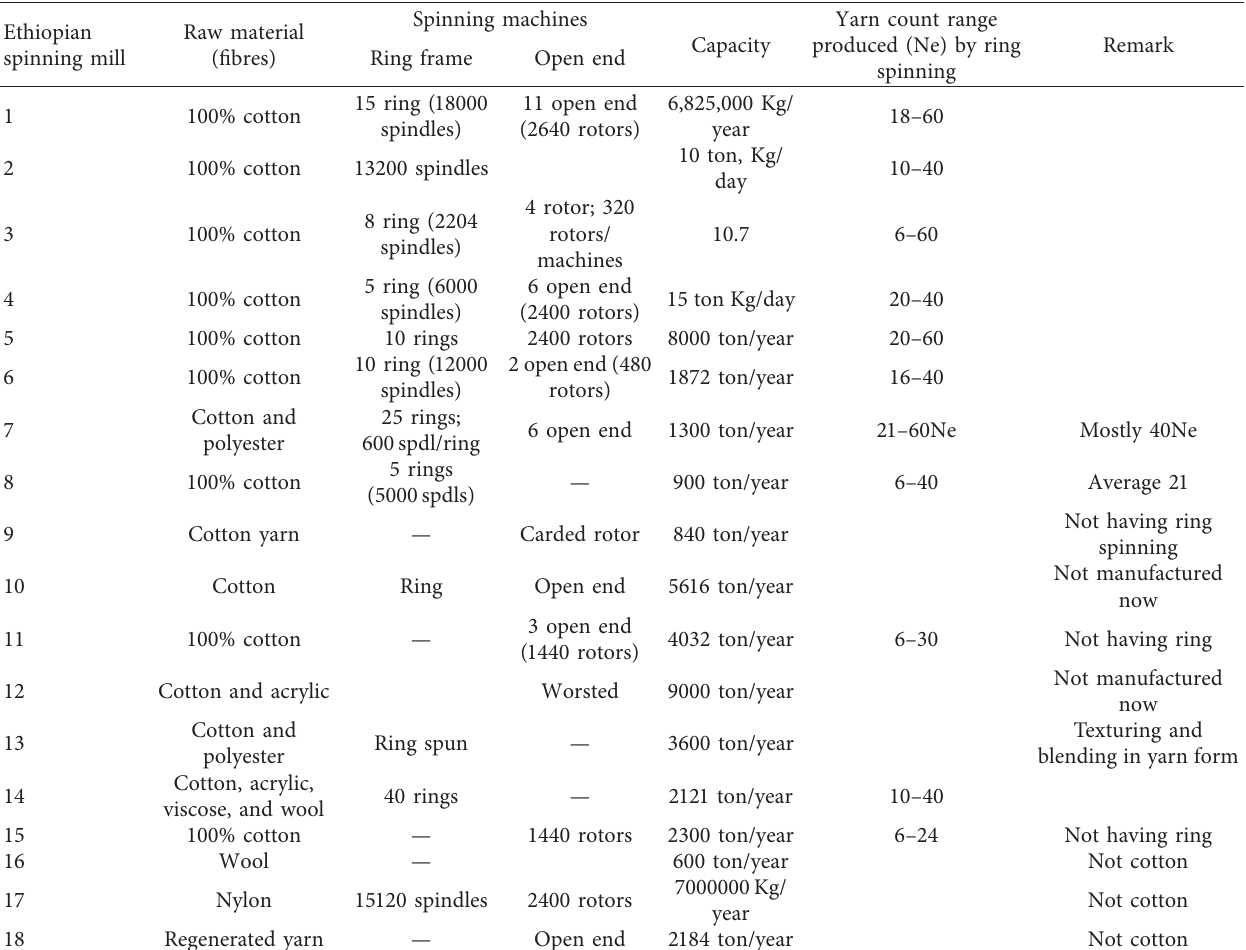
Table 1: Ethiopian spinning